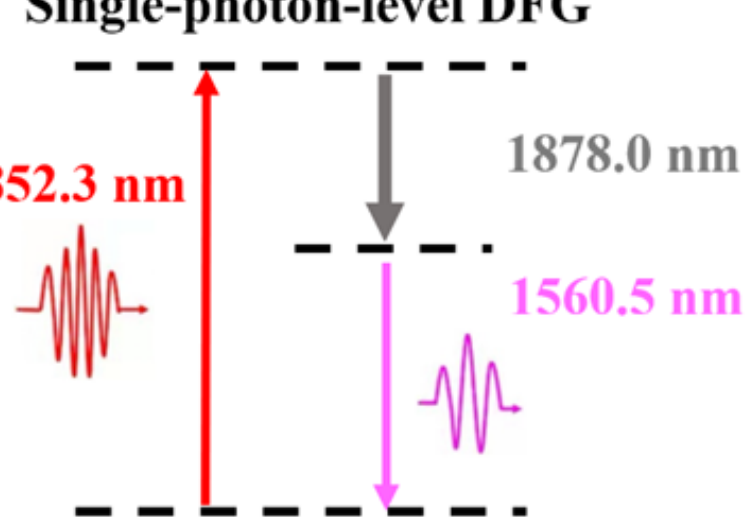
Figure 1. Conversion diagram of the difference frequency generation. The 852.3-nm single photon can be converted to 1560-nm telecom C-band based on 1878-nm long-wavelength pump